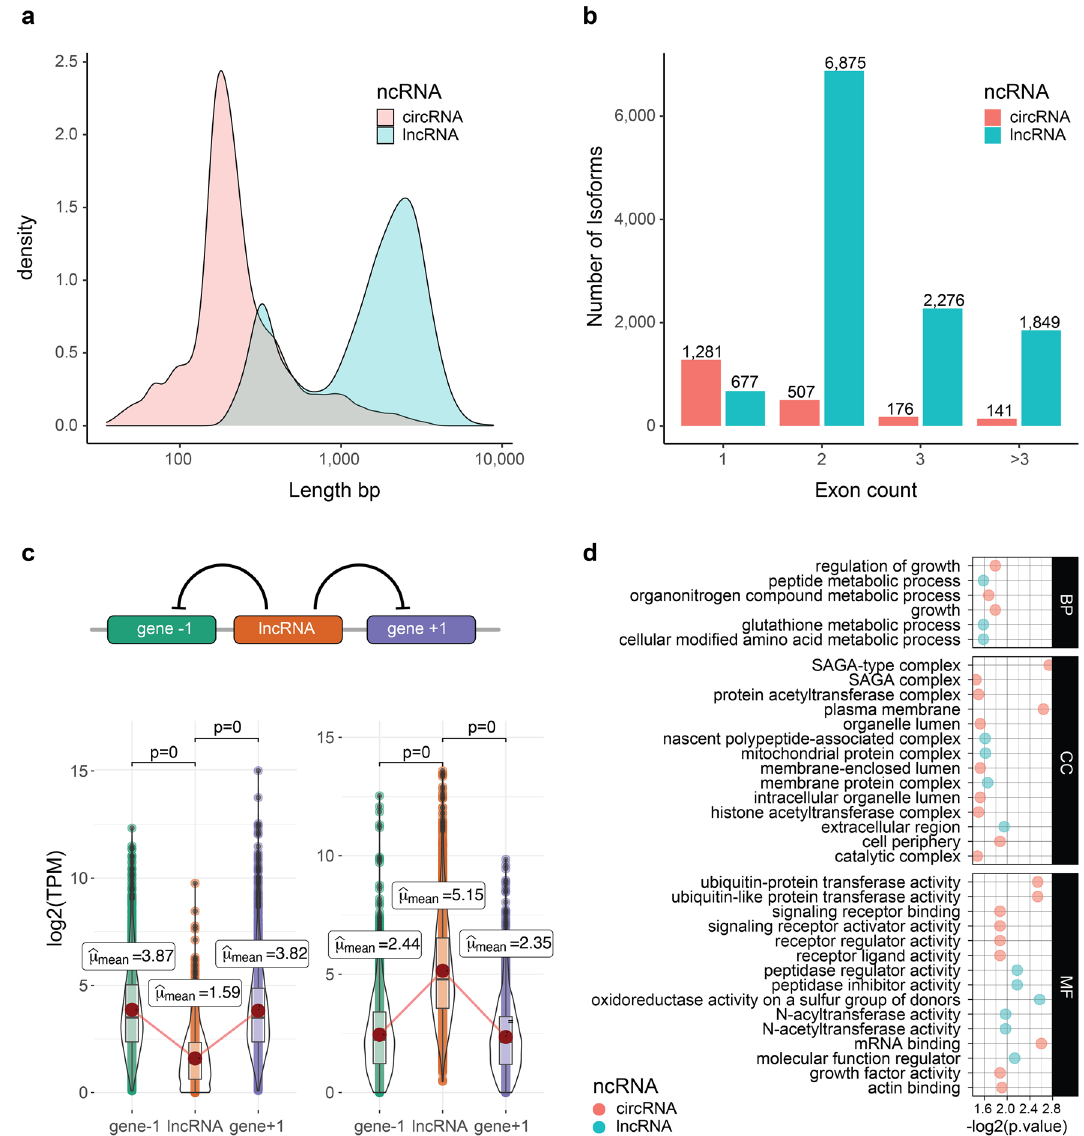
Figure 4. Analysis of noncoding RNAs in Medicago sativa . ( a ) Length distribution in bp for lncRNAs and circRNAs. ( b ) Exon count for lncRNAs and circRNAs. ( c ) Up: model for lncRNA regulation in adjacent genes. Down: histogram and violin plot for expression levels in log 2 TPM of gene -1 lncRNA and gene + 1. Only significative comparisons are shown based on p-Bonferroni − corrected. ( d ) Gene ontology enrichment for unique terms in lncRNAs and circRNAs in of biological process (BP), cellular component (CC) and molecular function